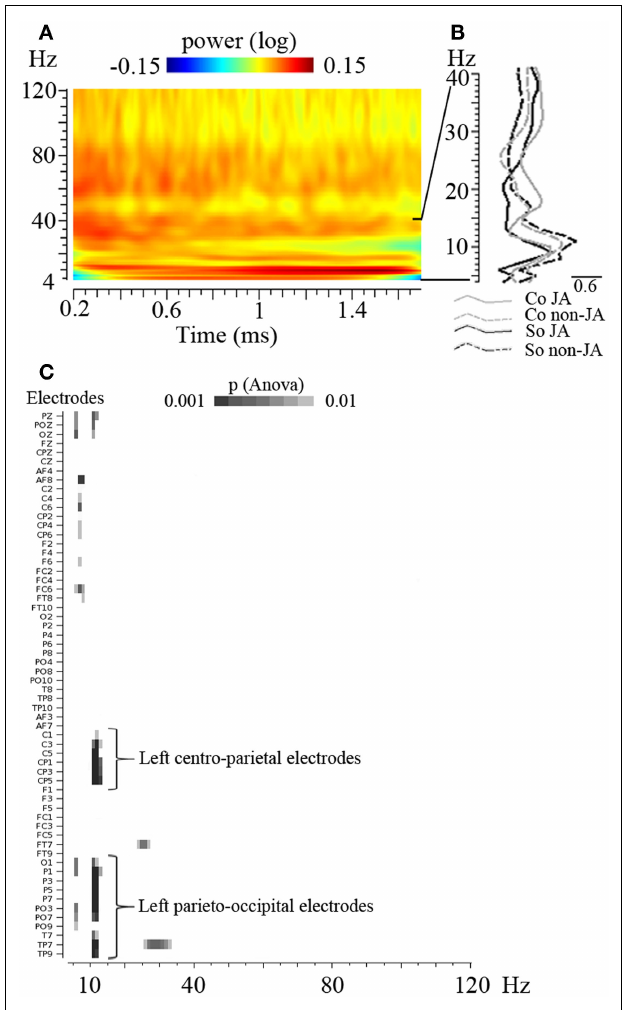
FIGURE 3 | Overall view of the EEG power spectrum and of the time-frequency analysis of the data. (A) Time-frequency plot representing the power of oscillatory activities between 4 and 120Hz across time (between 0.2 and 1.7s, before the averaging of data over this 1.5s period); the grand mean of the data, averaged across conditions, are represented on a selected electrode (C3). (B) EEG power spectrum between 4 and 40Hz, averaged over the 1.5s time interval, on the same electrode.This illustrates the peak of oscillatory activities obtained in the 10Hz frequency band. (C) Result of the overall ANOVA performed on every electrode (in ordinate) and every frequency between 4 and 120Hz (in abscissa). p -Values obtained for the main effect of Joint versus No-Joint attention are shown.This analysis did not reveal any other significant effect – with at least three electrodes reaching p < 0.001 – besides the identified 11–13Hz band modulation.